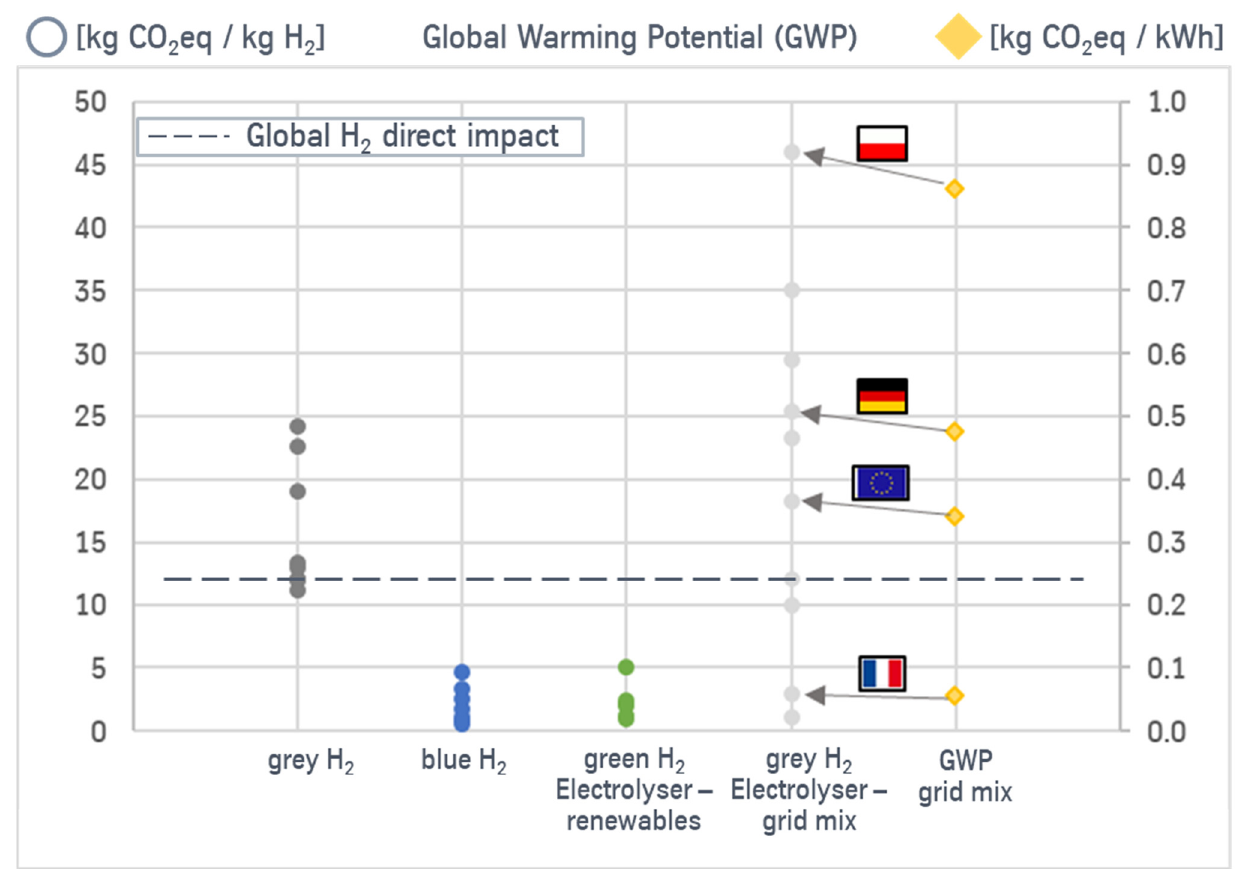
Figure 3. Impact of the electricity grid mixes on the related hydrogen carbon footprint for the nations of Poland, Germany, and France, and the European Union. The points for grey H 2 (from steam reforming), blue H 2 (steam reforming with carbon capture and storage), green H 2 (electrolysis using renewable energy), and grey H 2 electrolyser (electrolysis using fossil-based electricity) correspond to the values listed in Table 1.